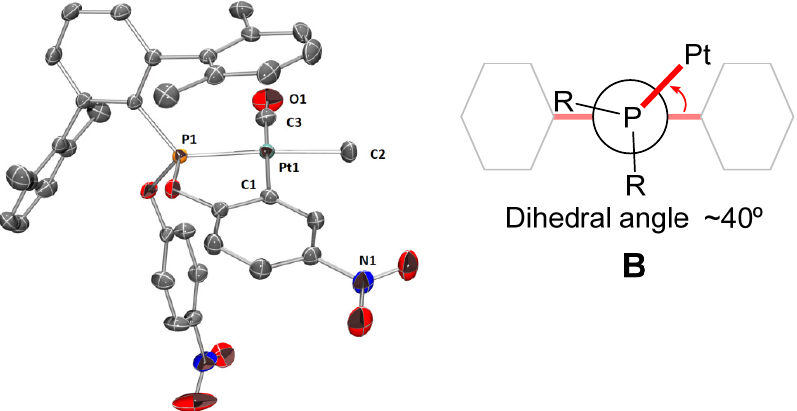
Figure 3. ORTEP view of the X-ray molecular structure of complex 1 · CO , with ellipsoids at the 50% probability level and H atoms omitted for clarity ( left ); schematic view of the B conformation adopted by the ligand PAr Xyl 2 (OPh NO 2 ) 2 ( right ) [18,26]. Selected bond distances (Å) and angles (°): Pt1-P1 2.2643(8), Pt1-C1 2.054(2), Pt1-C2 2.110(3), Pt1-C3 1.901(2), C3-O1 1.126(3); P1-Pt1-C1 80.86(6); C1-Pt1-C2 90.78(9); C2-Pt1-C3 88.06(1); C3-Pt1-P1 100.41(8).